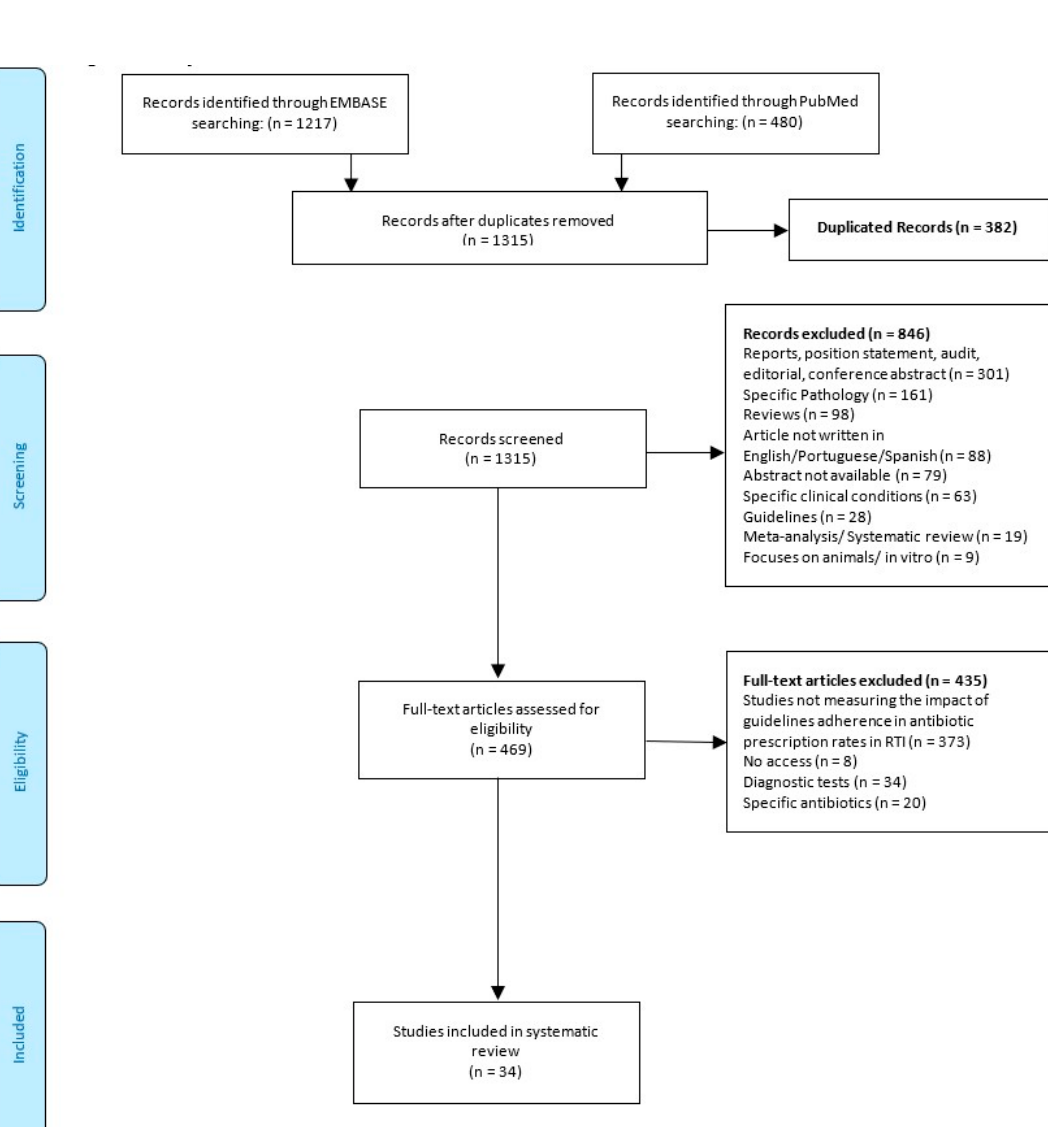
Figure 1. PRISMA (Preferred Reporting Items for Systematic Reviews and Meta-Analyses) flowchart.